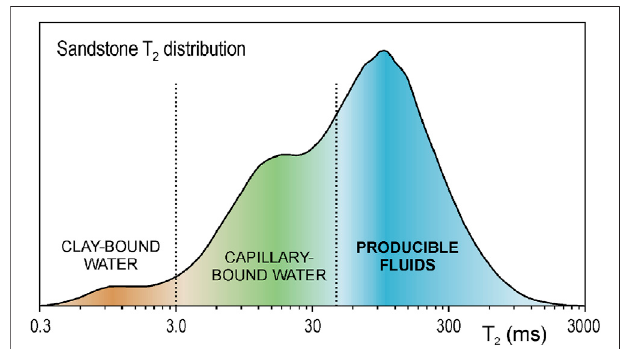
FIGURE 2 | T 2 distribution of a representative sandstone sample (adapted from Allen et al., 2000), in which the central value of the different relaxation mechanisms is indicated by graduated